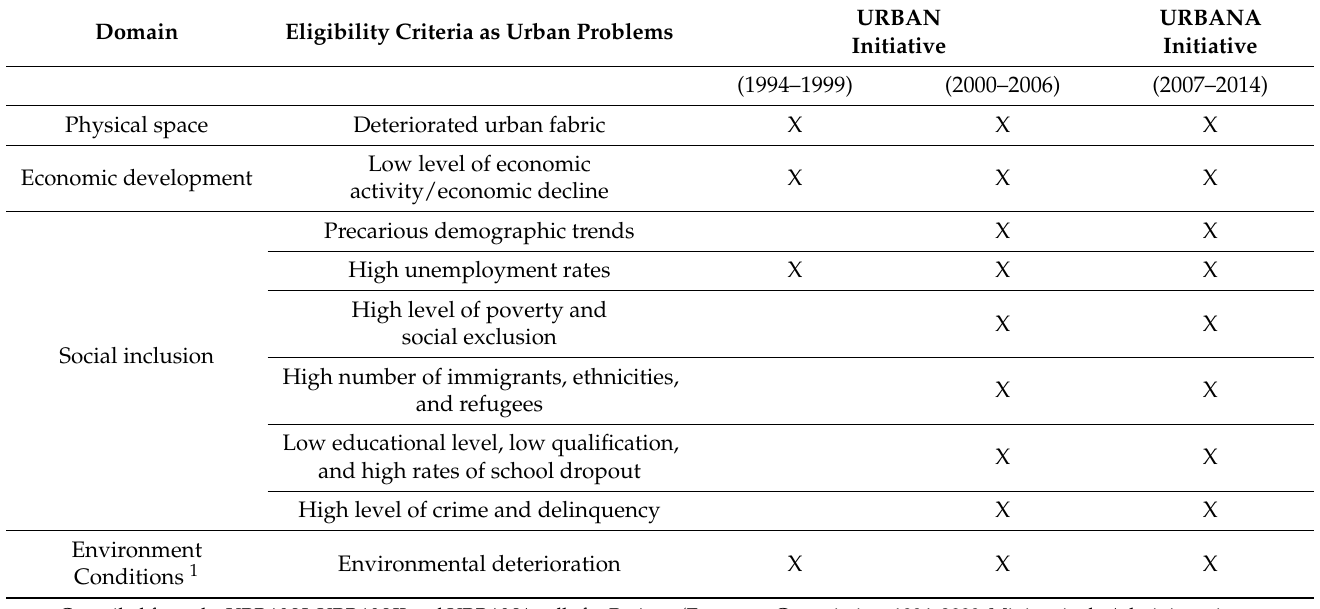
Table 2. Eligibility criteria in URBAN and URBANA